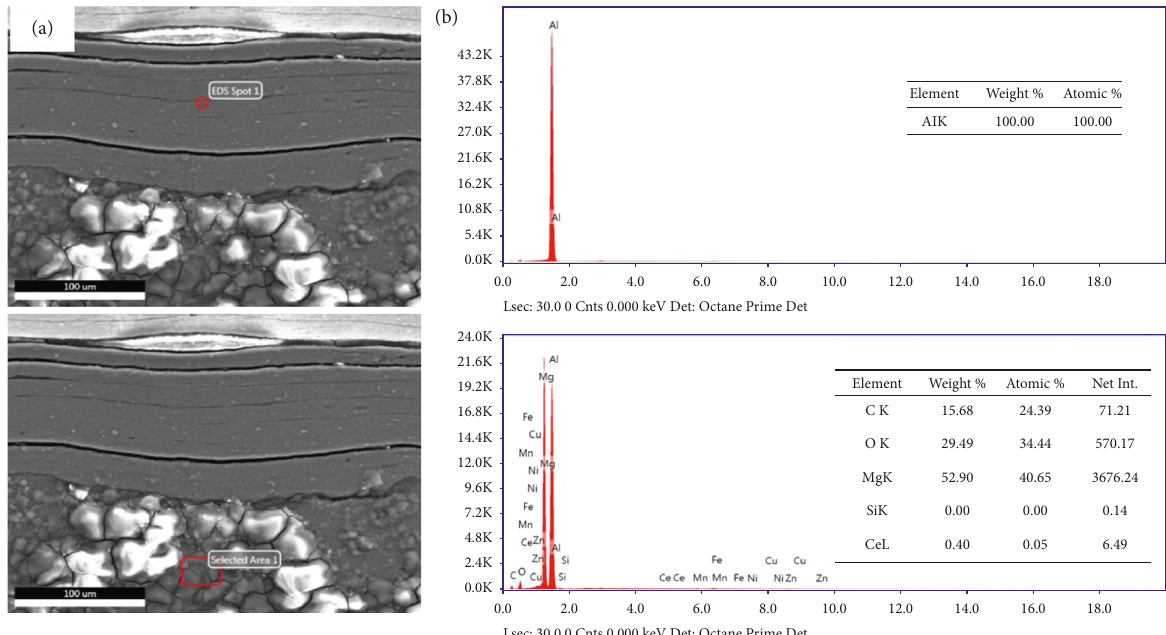
Figure 8: SEM images of Al powder-coated samples of AZ91D+0.1wt.% Ce+0.1wt.% Li Mg alloy.